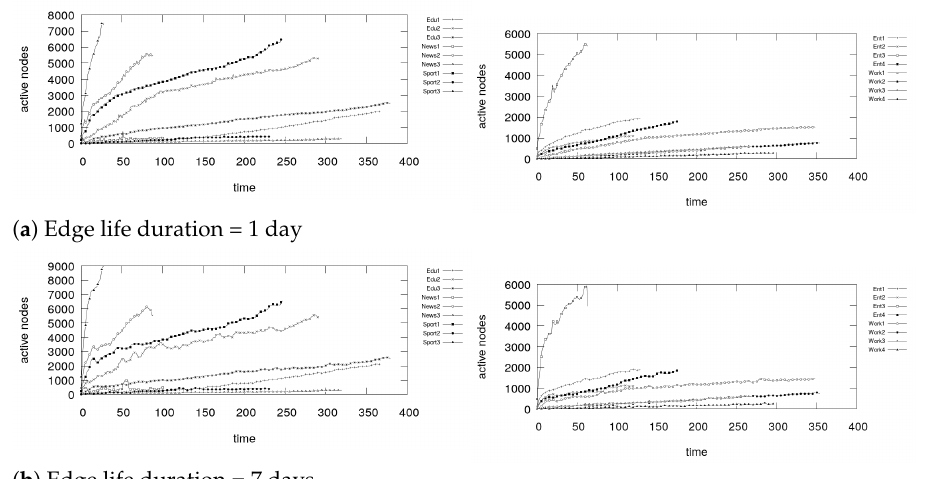
Figure 14. Number of active nodes detected by label propagation.